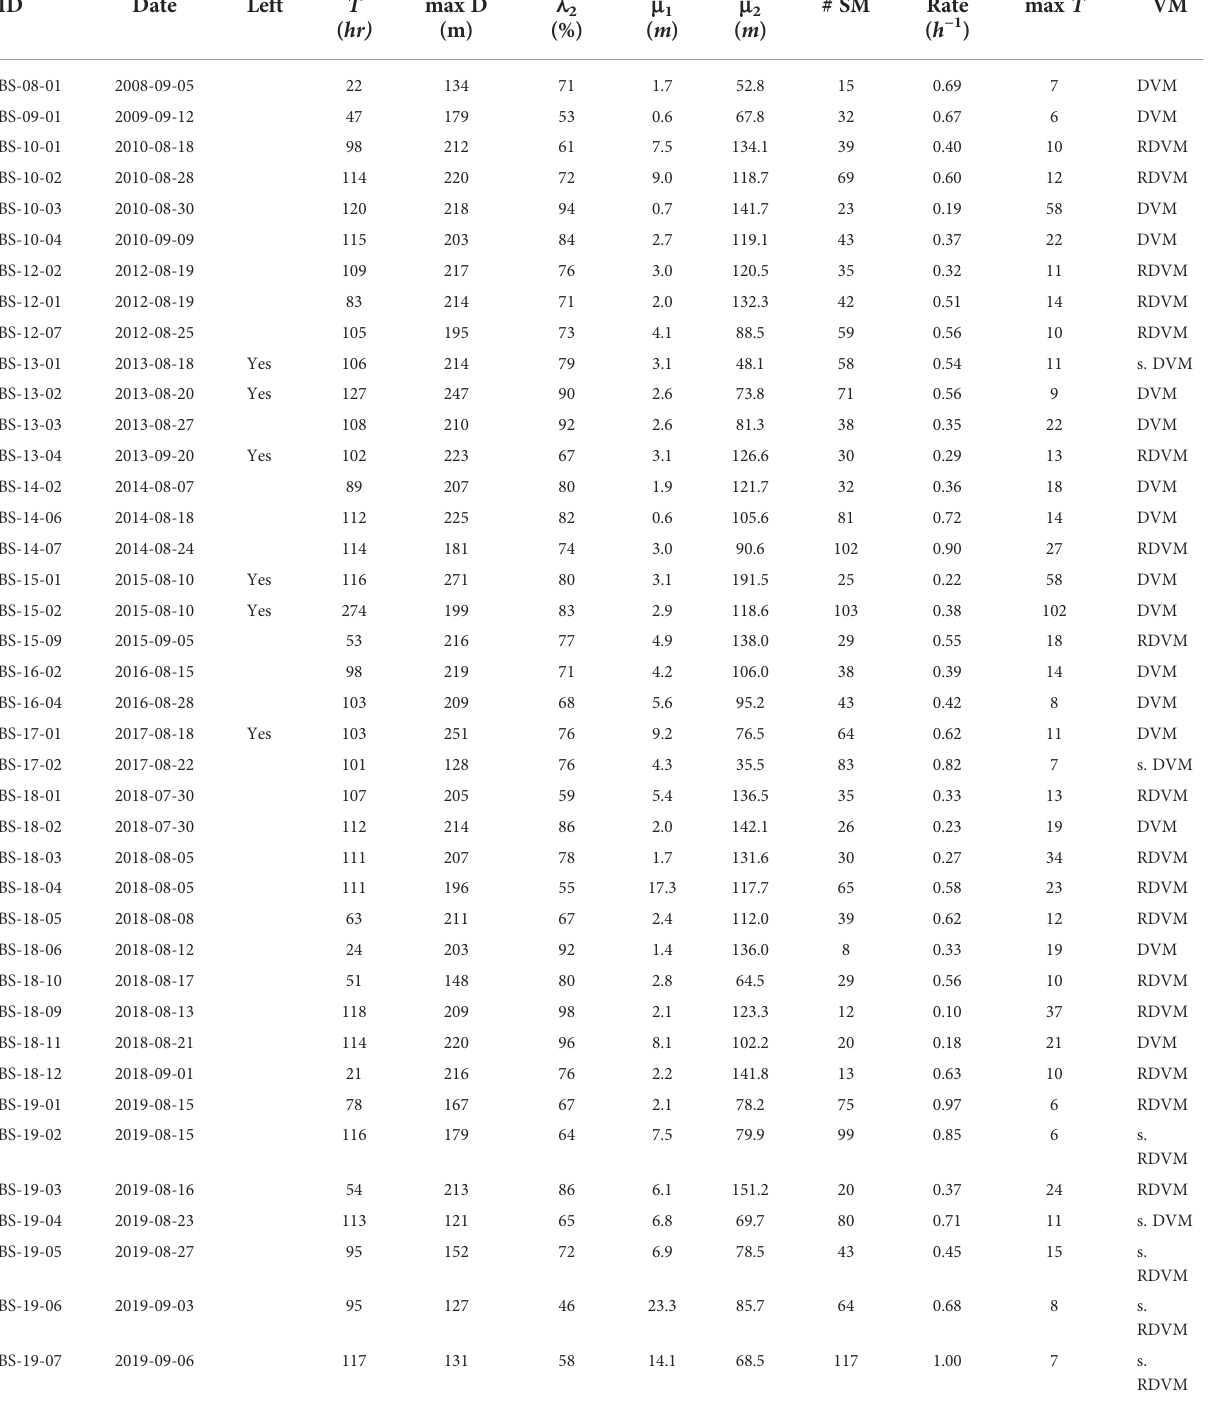
TABLE 1 Summary of the 42 basking sharks tagged with time-depth recorders in the Bay of Fundy, their identi fi cation code (ID), their deployment date, whether a deployment left the Bay of Fundy (Left), the length of the deployment in hours ( T ), the maximum depth recorded (maxD), the proportion of time spent in the subsurface component ( l 2 ), the mean of the surface component ( m 1 ), and the mean of the subsurface component ( m 2 ), the number of subsurface movements (# SM), the rate of subsurface movements per hour, the maximum length of the subsurface movements in hours (max T ) and the vertical migration pattern (VM) with categories: DVM for diel vertical migrator, RDVM for reverse diel vertical migrator, as well as a strong quali fi er (s.) (see Materials and Methods – DVM Assignment for classi fi cation scheme